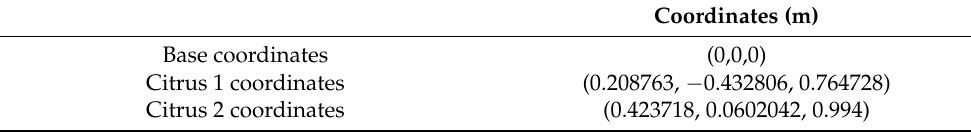
Table 8. Target information.